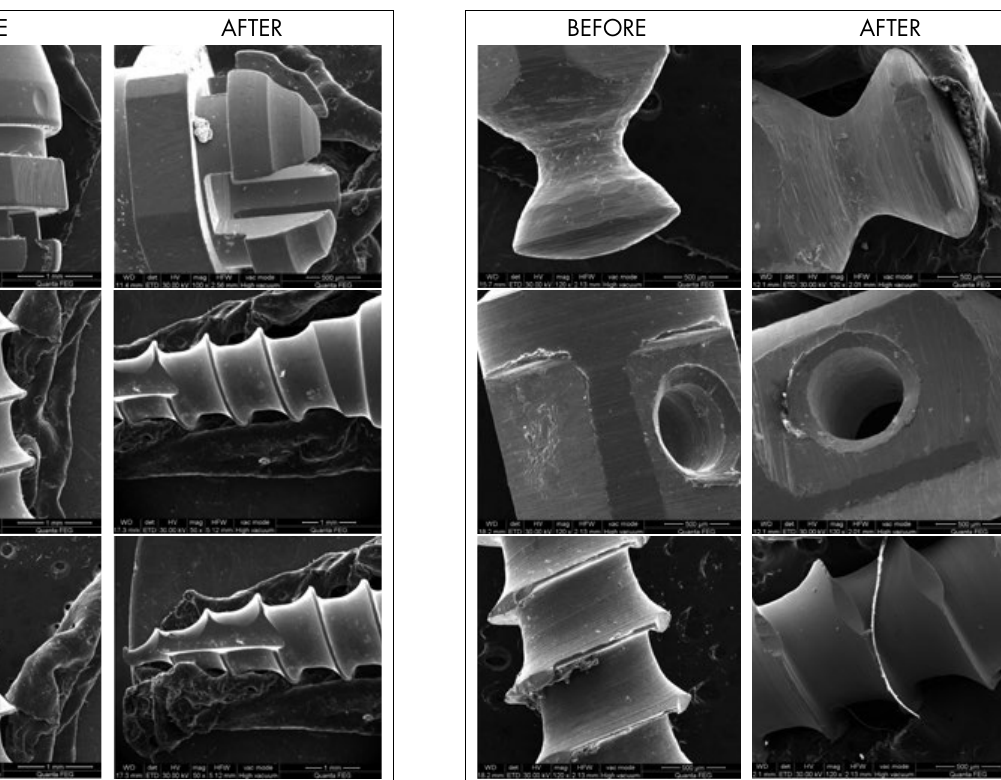
Figure 5. Back scattered SEM images of Group 3 mini-implants.